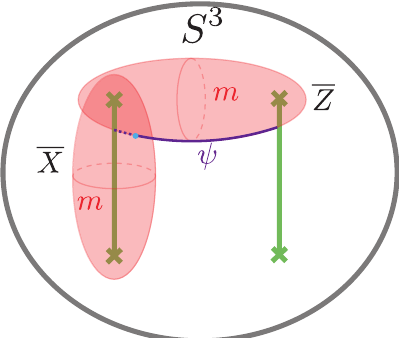
Figure 35: The anti-commuting pair of logical operators on a 3-sphere with a pair of open twist strings (4 point defects). The logical- X operator X = ξ is a Wilson m sheet operator (red) of flux string m supported on a 2-sphere enclosing an open twist = ξ ′ η ξ string. The logical- Z operator Z ψ is a product of Wilson sheet operator m 1 m (red) of flux string m supported on a 2-sphere encircling two point defects belonging to the two different twist strings and a worldline operator η ψ (blue) of the fermion charge ψ . The pair of open twist strings (four point defects or Majorana modes) encode a single logical